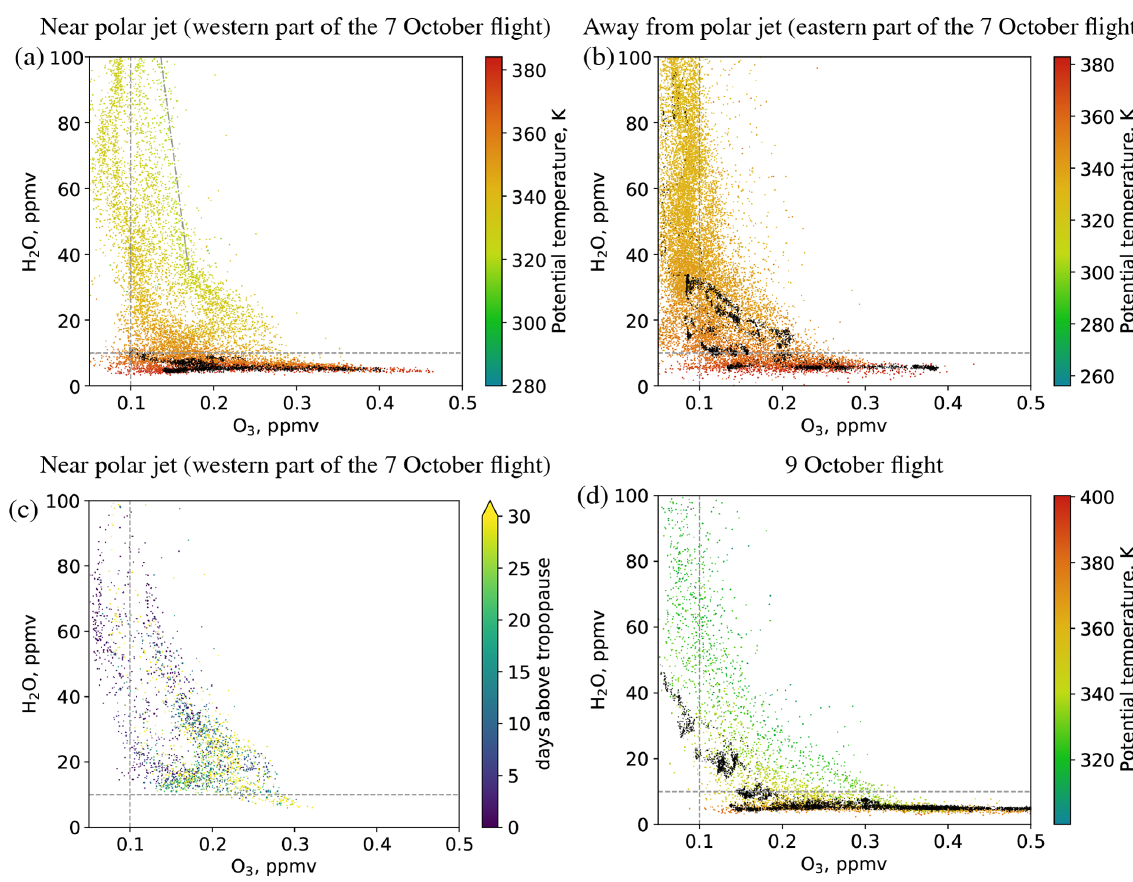
Figure 4. Ozone–water vapour tracer–tracer correlations. Black dots represent in situ measurements at flight altitude. O 3 was measured by FAIRO (Zahn et al., 2012); H 2 O – by FISH (Meyer et al., 2015). The dashed grey lines mark 0.1 and 10ppmv values of ozone and water vapour, respectively, as discussed in the main text. In panels (a, b, d) , GLORIA measurements are colour coded in potential temperature. In panel (c) , only stratospheric air parcels below θ = 350K are shown; all stratosphere residence times greater than or equal to 30d are depicted in the same